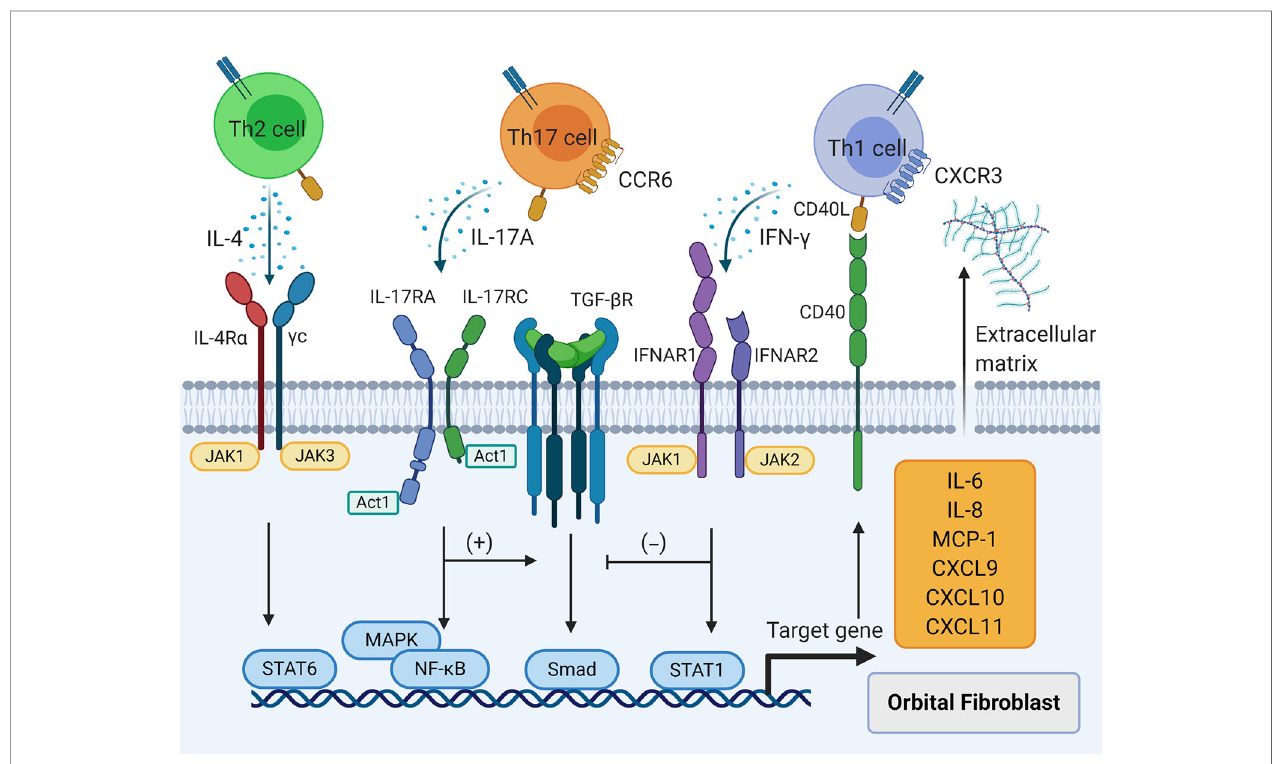
FIGURE 3 | The effects of T cell cytokines on orbital fi broblasts (OFs). T helper (Th) 1 cytokine interferon- g , Th2 cytokine interleukin (IL)-4, and Th17 cytokine IL-17A result in the production of IL-6, IL-8, macrophage chemoattractant protein-1, C-X-C motif ligand 9/10/11, and extracellular matrix in OFs. Interferon – g interferes with transforming growth factor- b induced fi brosis in OFs while IL-17A strengthens this